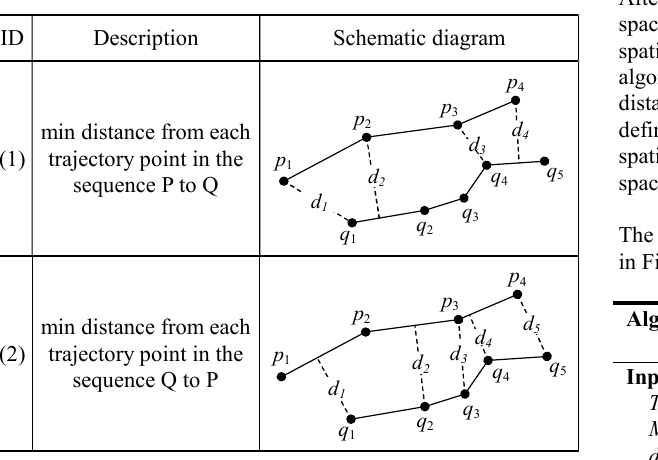
Table 2. Spatial distance description method for spatiotemporal trajectory